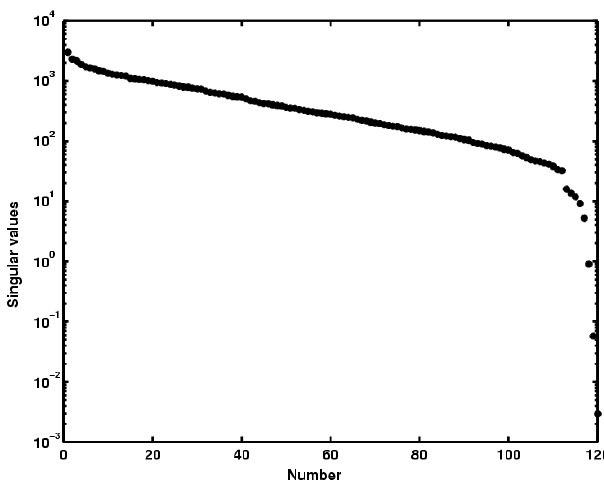
Fig. 7. Distribution of singular values for the geometric matrix